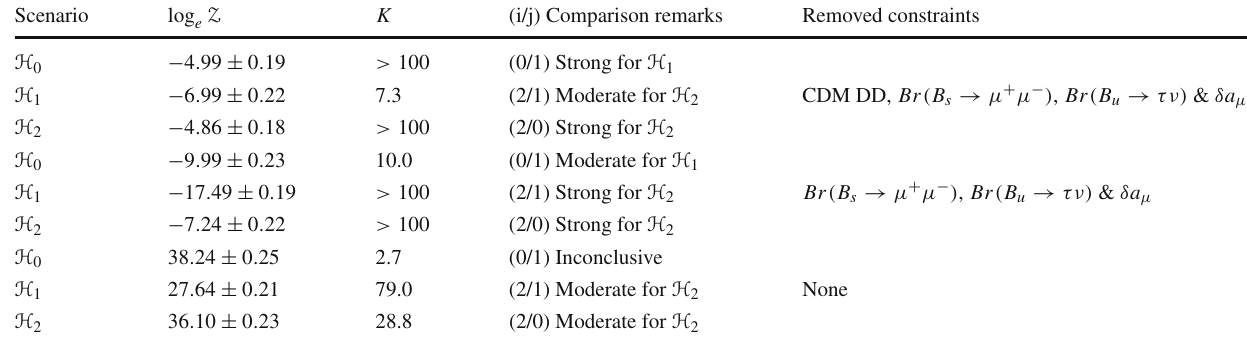
Table 4 but without the CDM direct detection (DD), Br ( B s → μ + μ − )